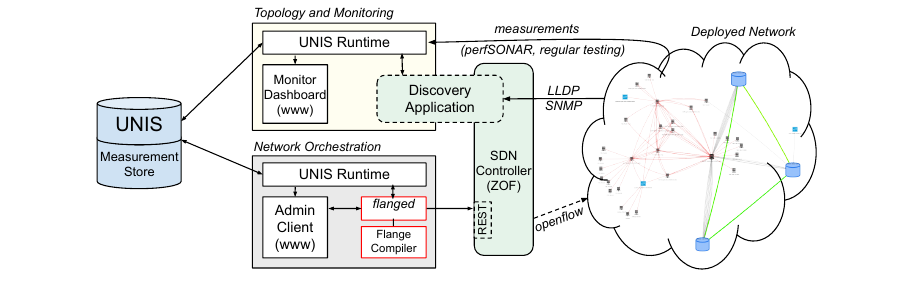
Figure 1. High-level diagram of key NMAL